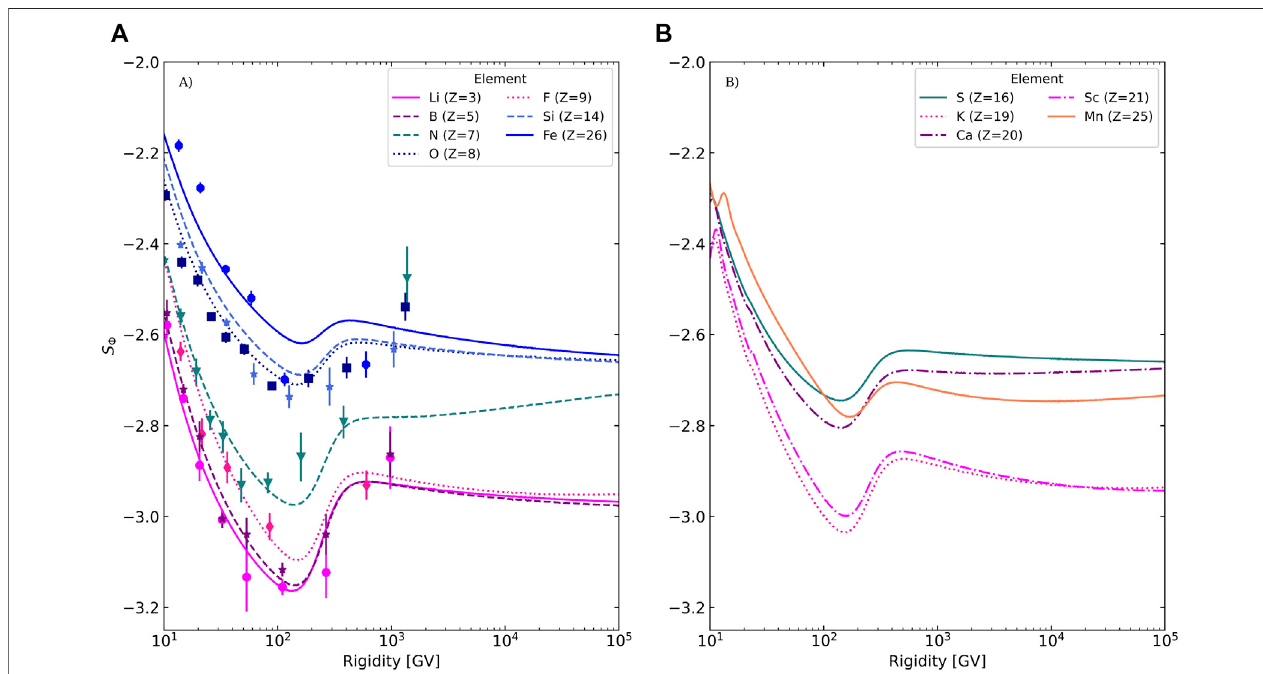
FIGURE 3 | The two panels show logarithmic slopes of TOA fl uxes: in the left panel (A) , for a selection of elements already analysed by the AMS-02 collaboration (symbols,Aguilaretal.1);intherightpanel (B) ,foraselectionofelementsaccessibletotheAMS-02detector.ThevariouslinescorrespondtoourcalculationintheSLIM con fi guration. See text for